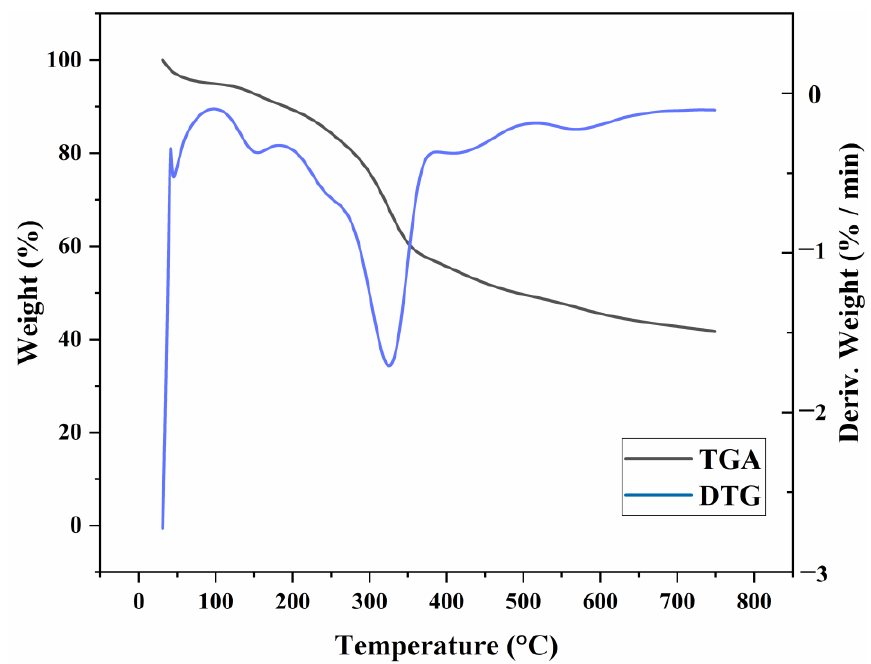
Figure 5. Thermal stability of the PNMBC biosorbent (TOCN – PEI:MB = 1:1).